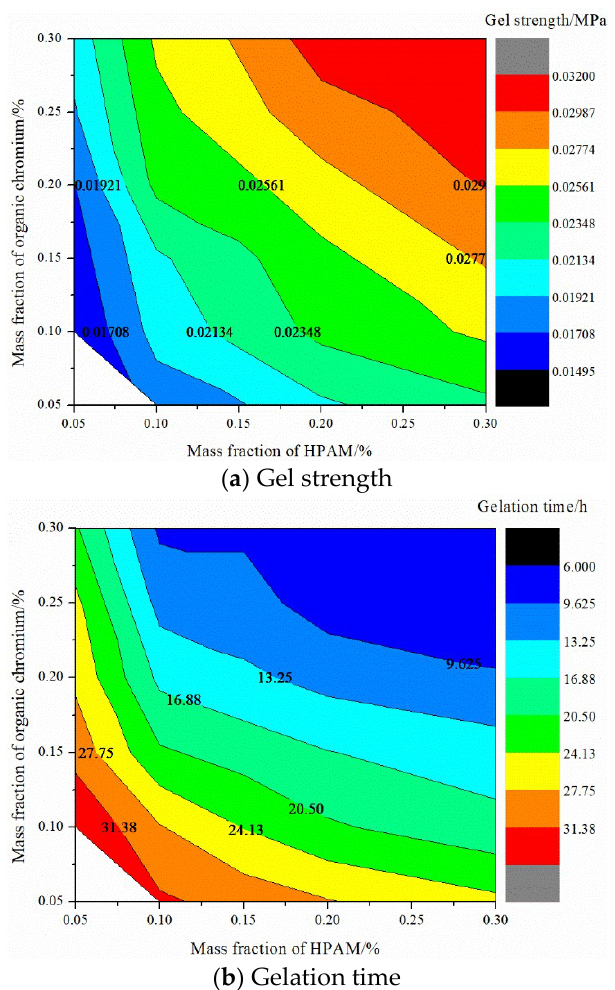
Figure 11. Contour diagrams of the static performance of organic chromium gel. Table 5. Stability evaluation of the gel and nano-SiO 2